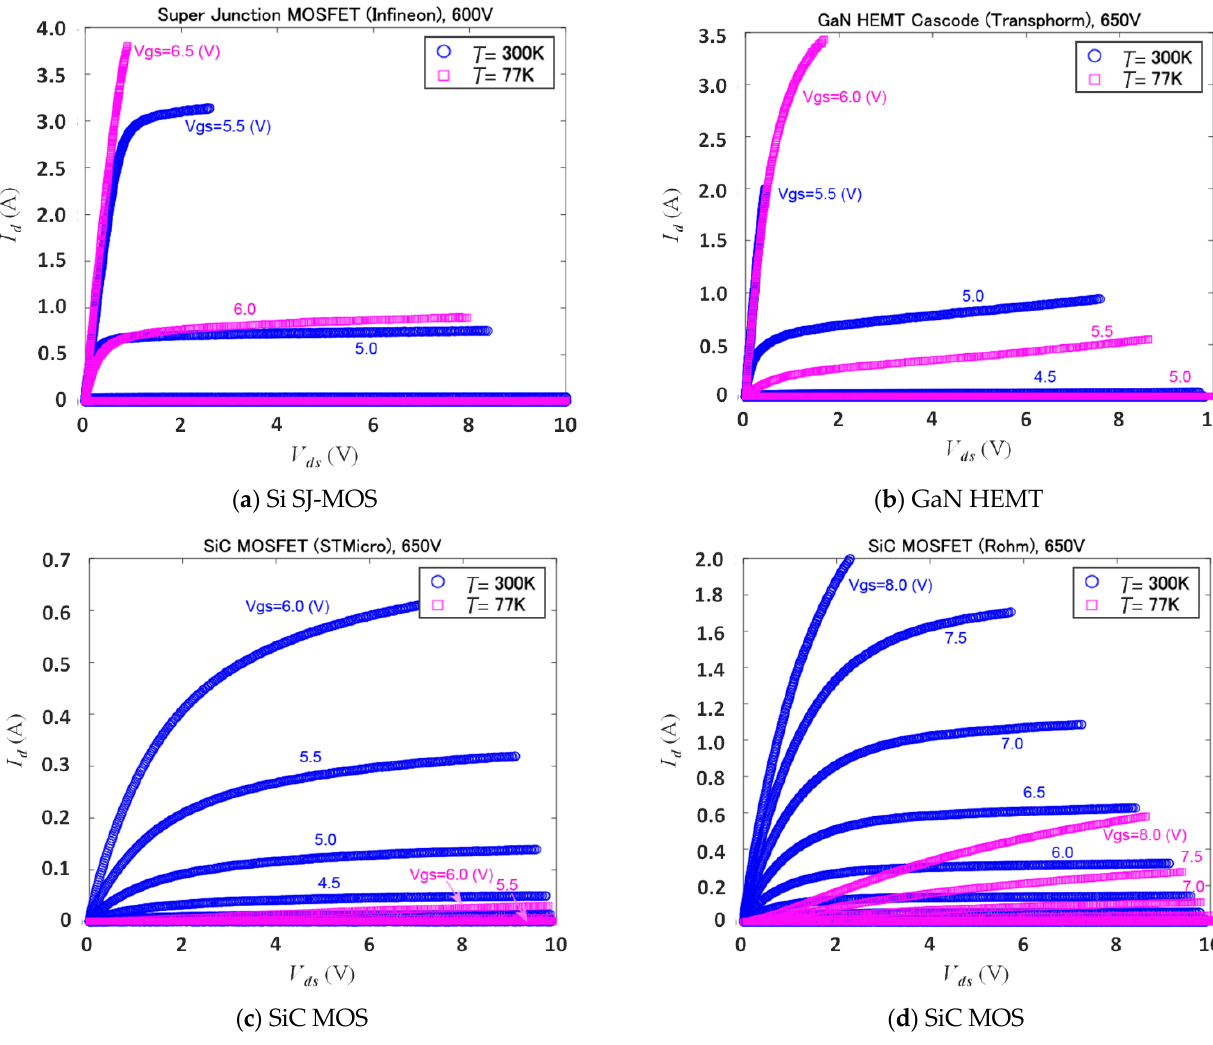
Figure 8. The experimentally measured drain characteristics at 300 K and 77 K. Table 2. Summary of the characteristics of power switches.